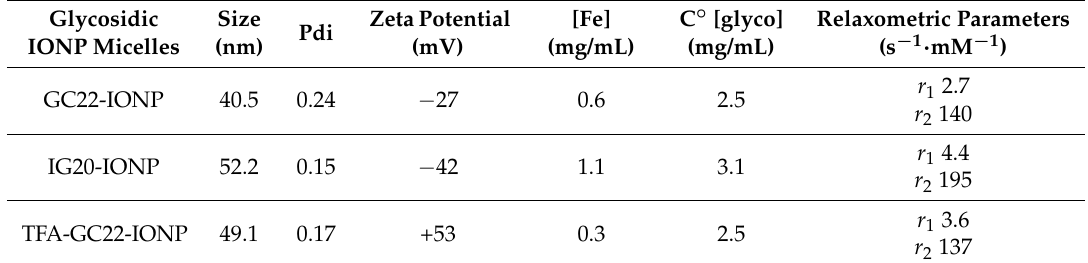
Table 2. Main physicochemical characteristics of the glycosidic IONP micelles. Zeta Glycosidic Size Pdi IONP Micelles (nm)